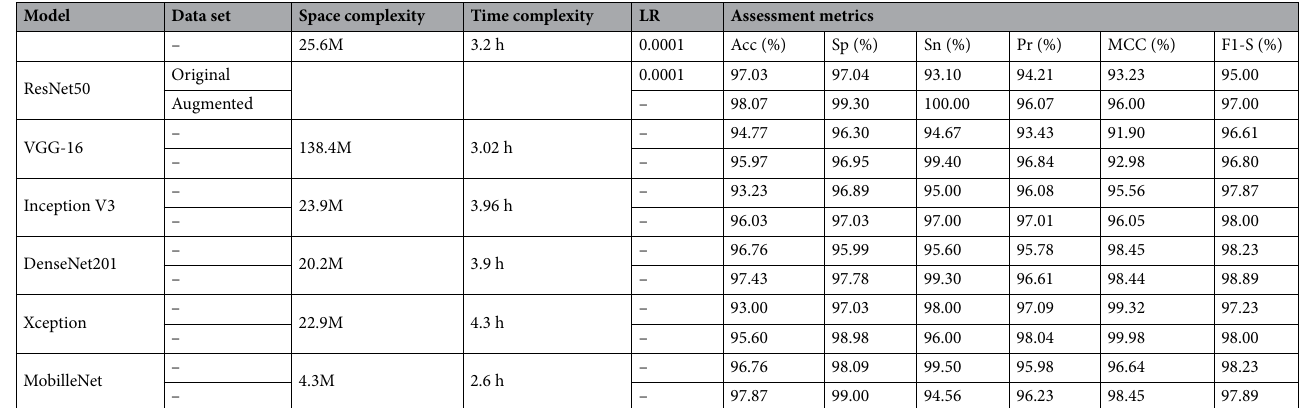
Table 3. Transfer learning models predictive performance on original and augmented data sets. The space complexity of each model is the number of trainable parameters. M = Million. The space complexity increases with increasing number of trainable parameters. The time complexity is the training time (in hours) of the